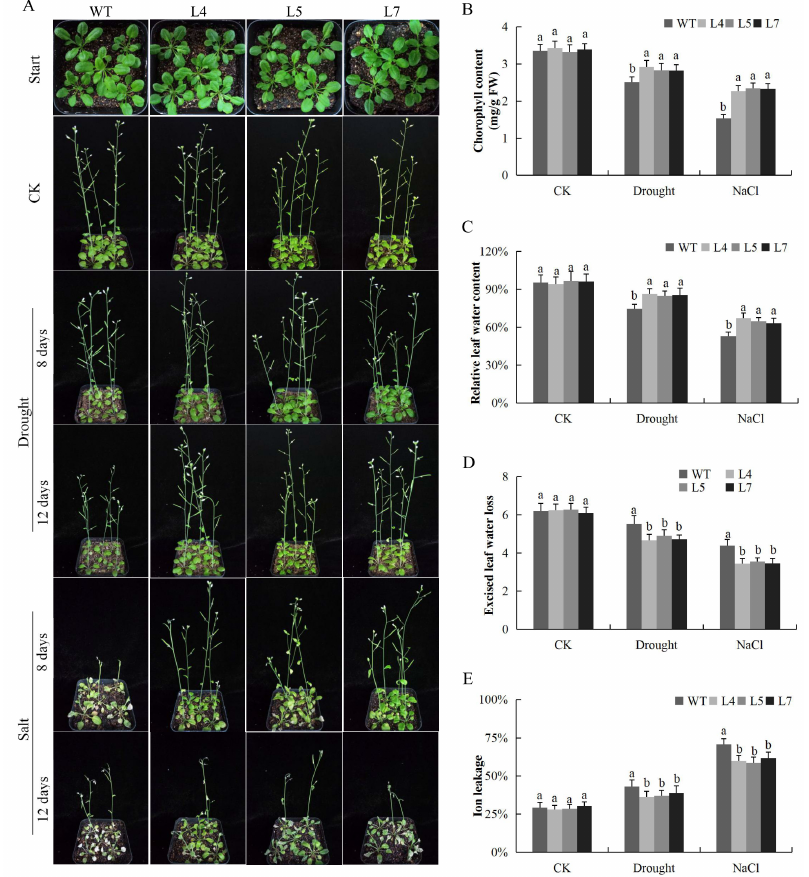
Figure 9. Determination of physiological traits ( A ) Transgenic Arabidopsis lines and wild type under abiotic stress conditions ( B ). chlorophyll content determination ( C ) Quantitative determination of relative water content (RLWC) ( D ) Quantitative determination of excised leaf water loss ELWL ( E ) Quantitative determination of cell membrane stability (CMS) as ion leakage concentration in leaves of wild type and transgenic Arabidopsis lines (L4, L5 and L7) after 8-day post stress exposure. Each experiment was repeated three times. Bar indicates standard error (SE). Different letters indicate significant differences between wild type and transgenic Arabidopsis lines (ANOVA; p < 0.05). CK: normal